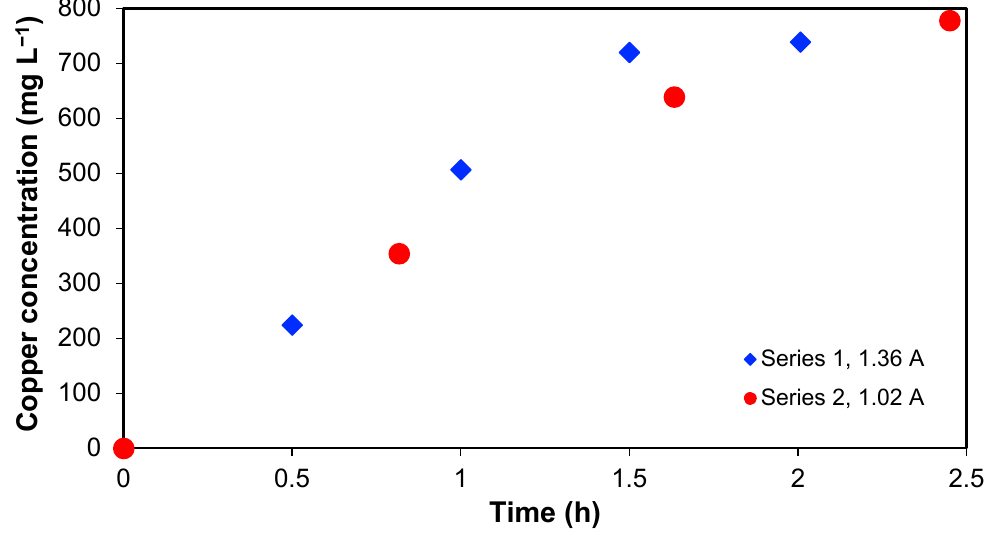
Figure 3. Percentage of arsenic in Sections 3 and 4 over time ( a ) Series 1, ( b ) Series 2.